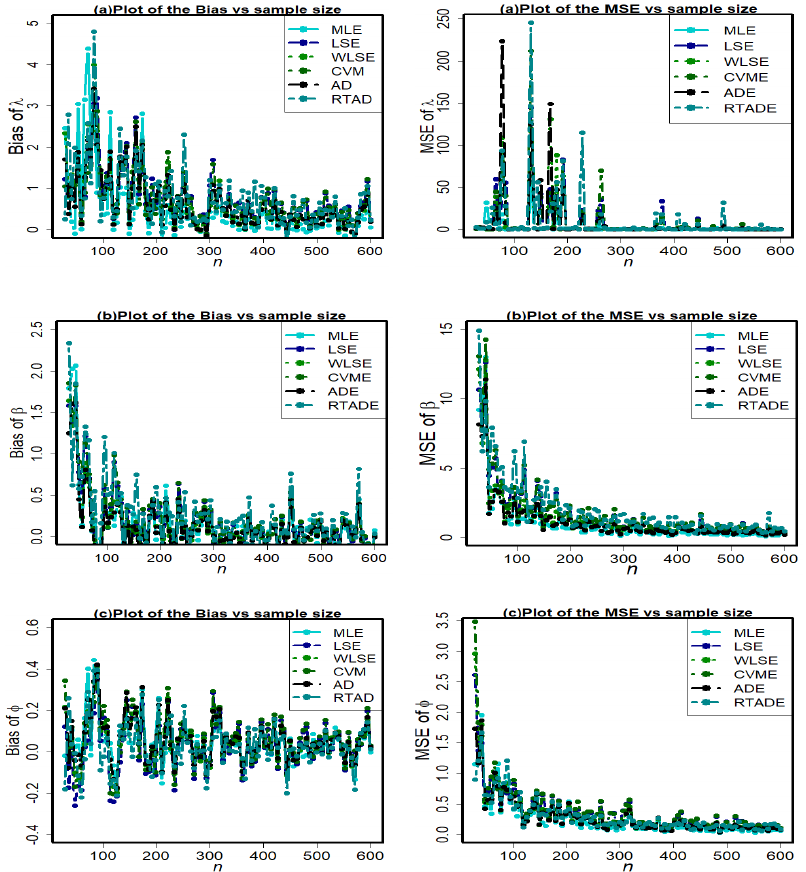
Fig. 10. Plots of biases and MSEs for the parameters (cid:21) = 1 : 9 ; (cid:12) = 2 : 3 and (cid:30) = 2 : 6 of HLUG-TI Figure 10. Plots of biases and MSEs for the parameters λ = 1.9, β = 2.3 and φ = 2.6 of HLUG- model. TI